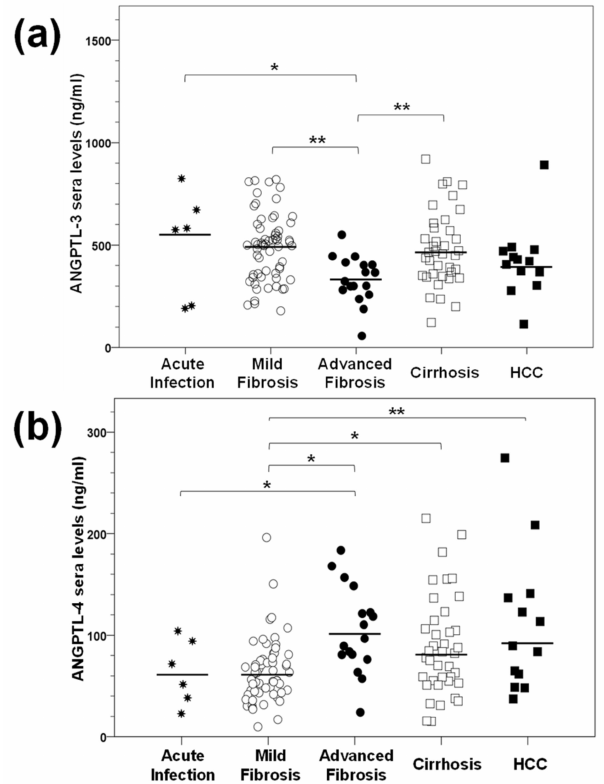
Figure 2. ANGPTL-3 and ANGPTL-4 serum levels throughout the natural history of HCV infection. Clinical samples of HCV patients from all stages of liver disease were used for the determination of ANGPTL-3 ( a ) and ANGPTL-4 ( b ) serum concentrations by ELISA. The black horizontal lines depict the median value of the respective group. Statistically significant differences within groups are denoted by one star ( p -value ≤ 0.05), or two stars ( p -value ≤